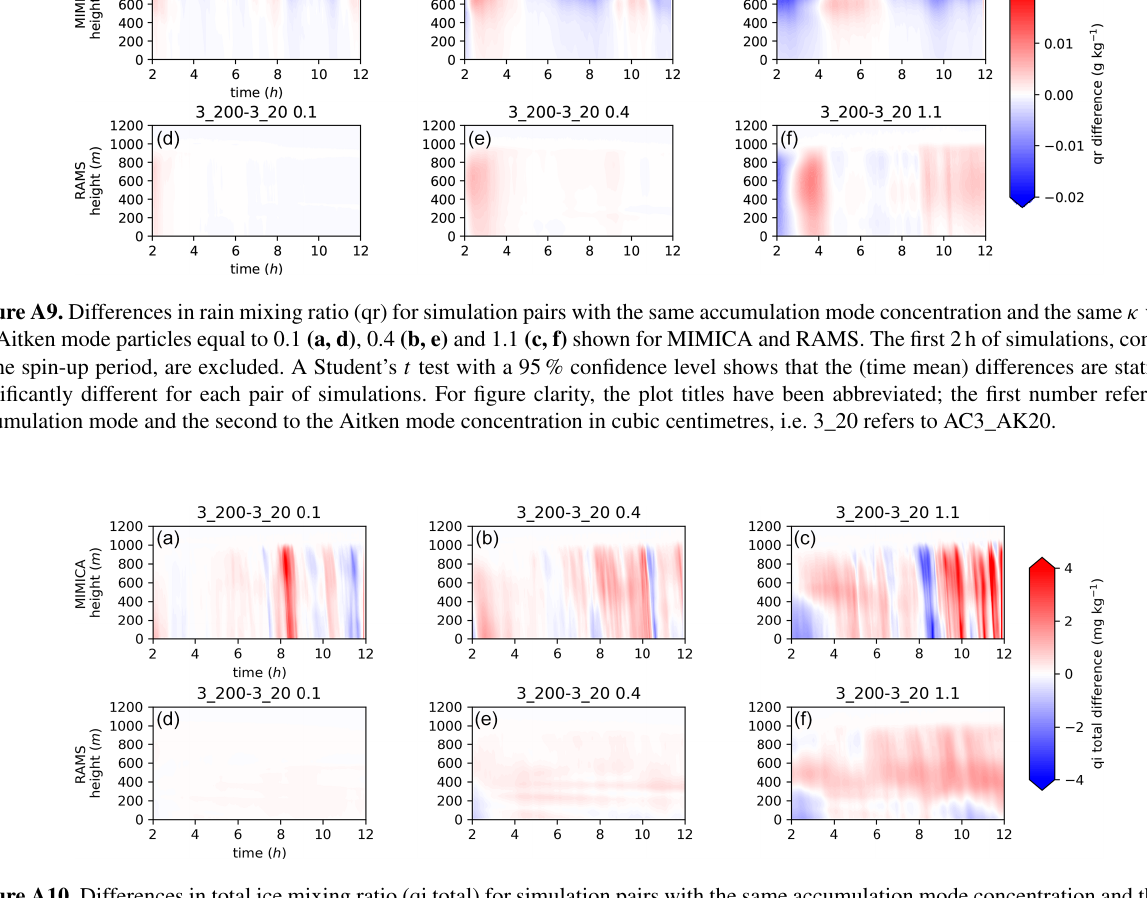
Figure A10. Differences in total ice mixing ratio (qi total) for simulation pairs with the same accumulation mode concentration and the same κ value of the Aitken mode particles equal to 0.1 (a, d) , 0.4 (b, e) and 1.1 (c, f) shown for MIMICA and RAMS. The first 2h of simulations, considered as the spin-up period, are excluded. A Student’s t test with a 95% confidence level shows that the (time mean) differences are statistically significantly different for each pair of simulations. For figure clarity, the plot titles have been abbreviated; the first number refers to the accumulation mode and the second to the Aitken mode concentration in cubic centimetres, i.e. 3_20 refers to